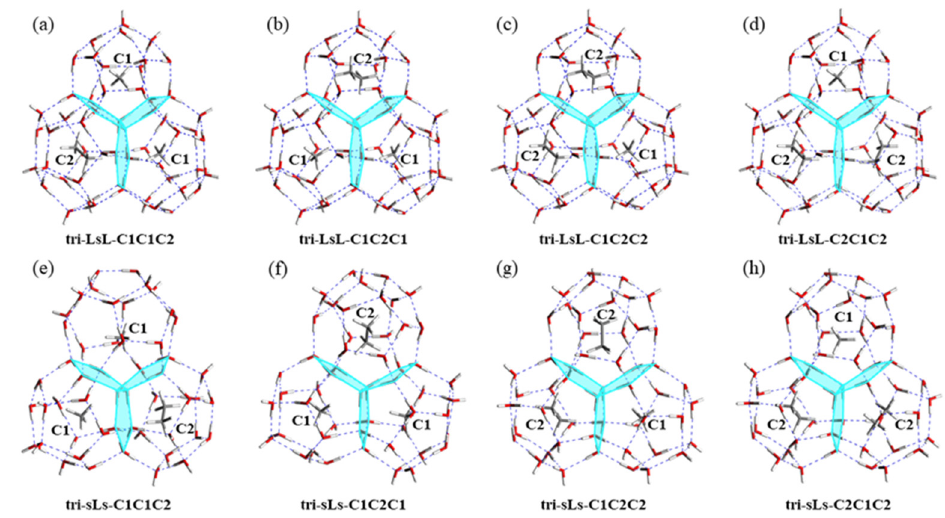
Figure 4. The optimized tri-cage structures, in which pentagonal water rings were shared in two small cages and mixed double cages, and hexagonal water rings were shared in two large cages.